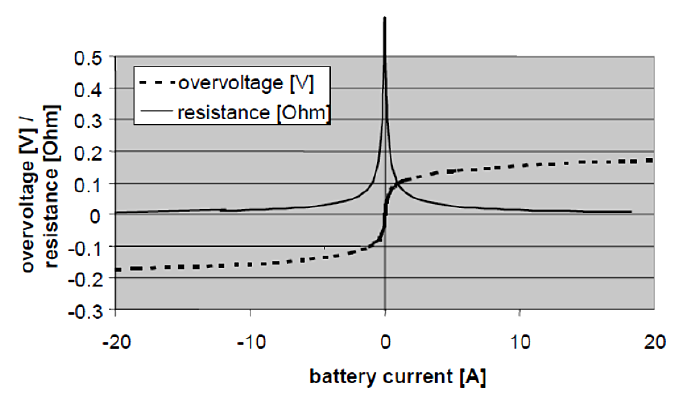
Figure 29. Butler-Volmer representation